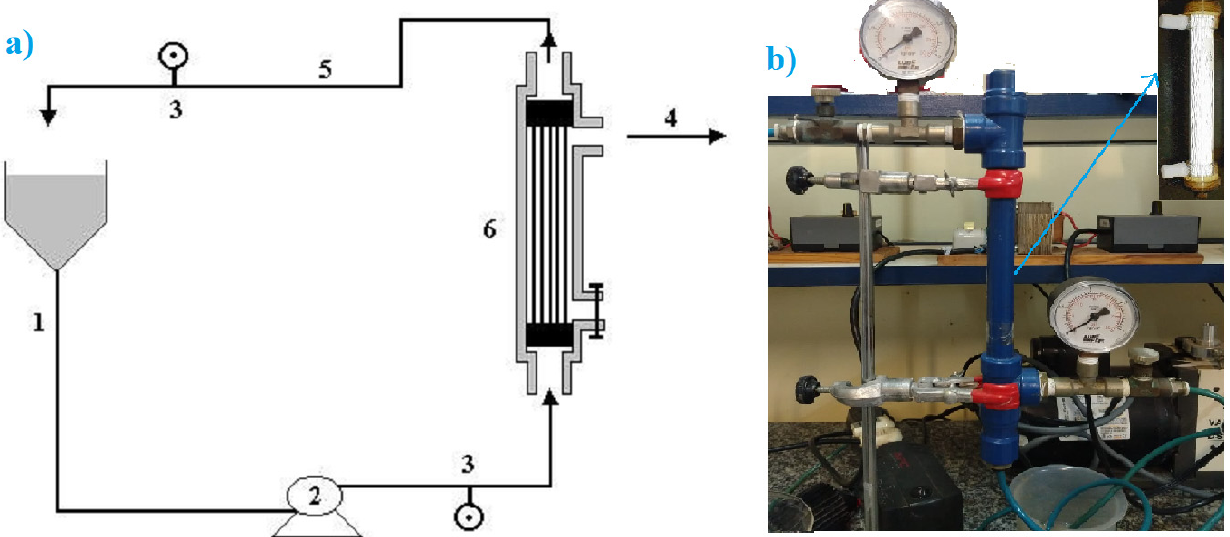
Figure 2. Experimental MMHF-01 Microfiltration Unit (1—Feed flux; 2—Pump; 3—Pressure meter; 4—Filtration flux; 5—Concentrate flux; 6—Hollow fiber membrane). ( a ) Scheme and ( b ) photo of the filter membrane system.